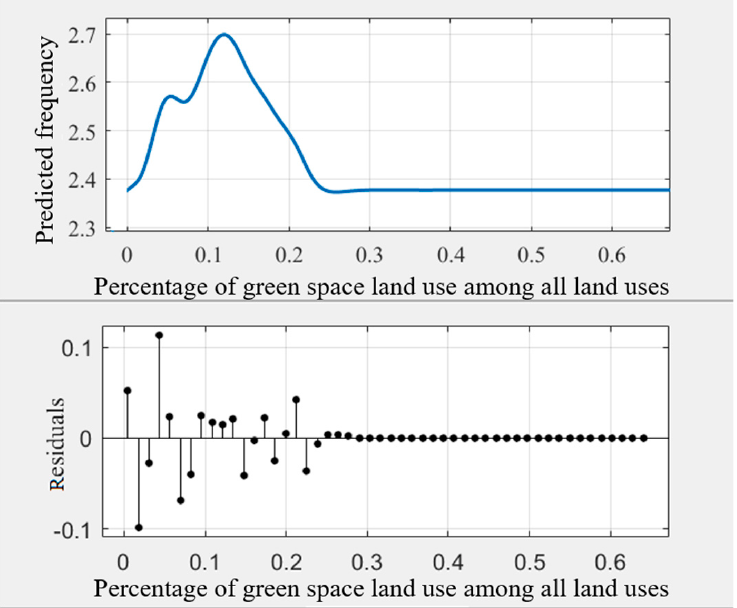
Figure 6. Nonlinear associations between the percentage of green space land use among all land uses (GREEN) and cycling frequency among older adults.